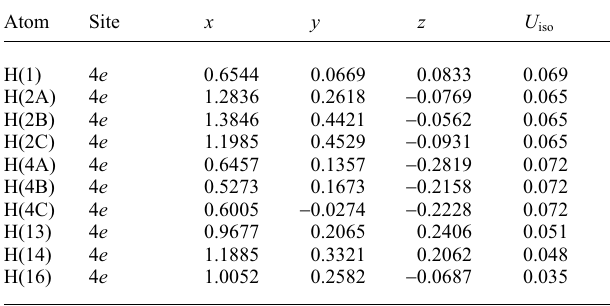
Table 2. Atomic coordinates and displacement parameters (in Å 2 ) .